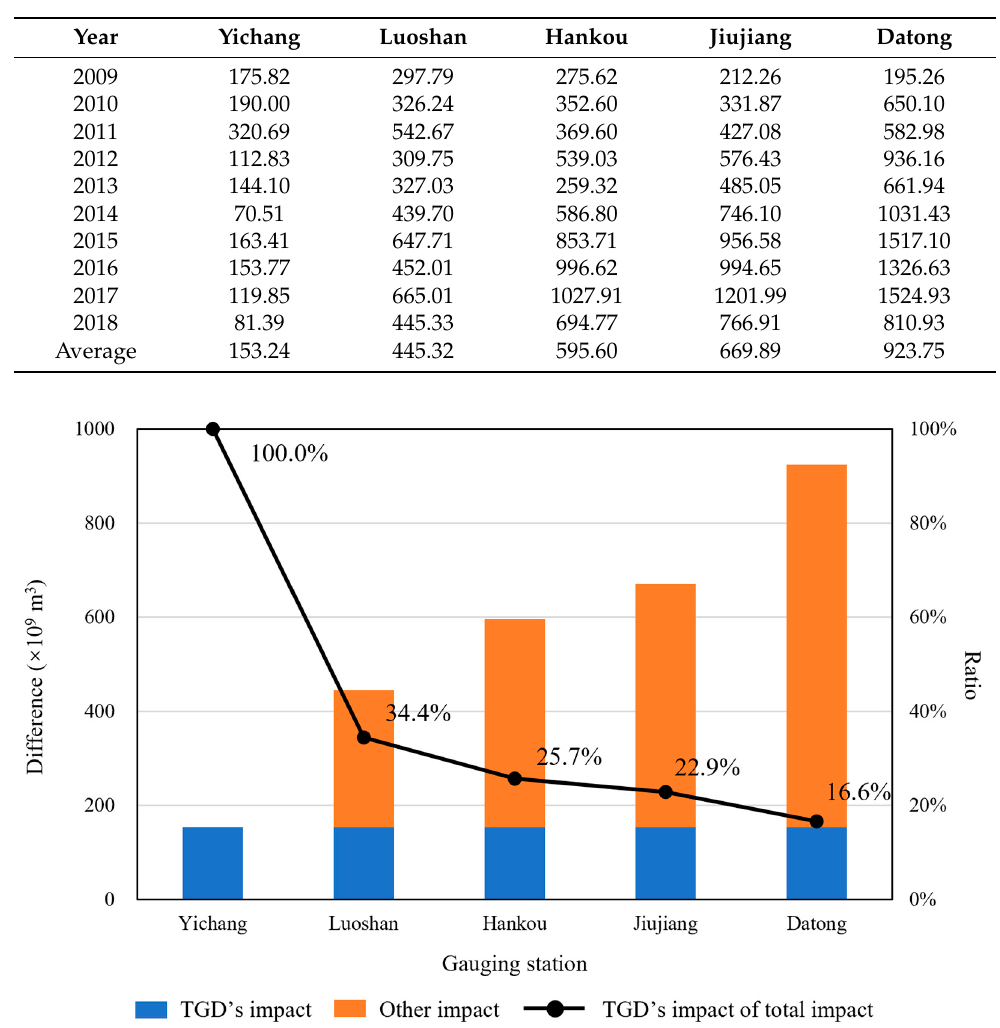
Figure 14. The TGD’s impact on five gauging stations based on an analysis of the flood season runoff. These results were calculated from the average of the difference between the observed flood season runoff and the reconstructed flood season runoff after the full operation of the TGD (see Table 6). The TGD’s impact on the Luoshan, Hankou, Jiujiang, and Datong gauging stations is equal to the TGD’s impact on the Yichang gauging station, assuming that the Yichang gauging station is completely controlled by the TGD.